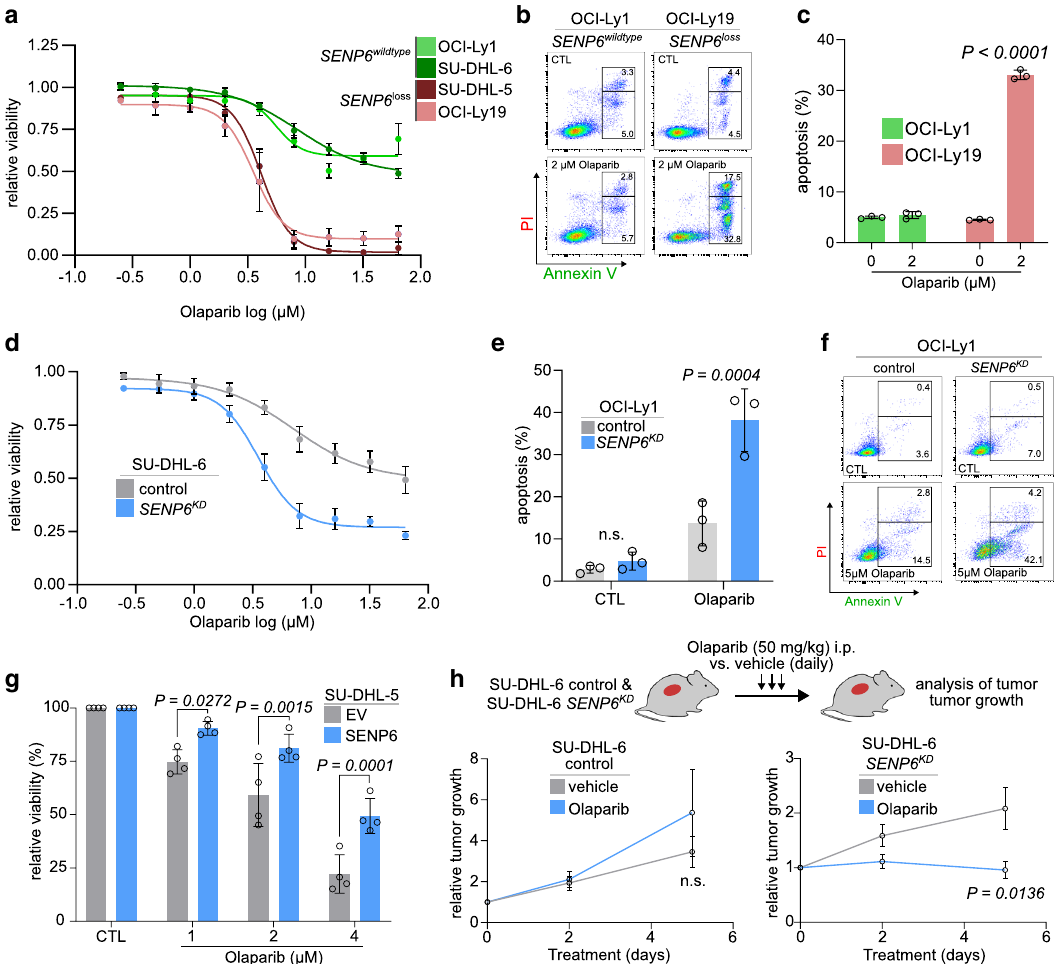
Fig. 7 SENP6 de fi ciency drives synthetic lethality to PARP inhibition. a Olaparib dose-response curves for two SENP6 wildtype and two SENP6 loss human DLBCL cell lines. Cells were treated for 72 h with olaparib and viability was determined by PI staining and fl ow cytometry measurement. Data are presented as mean ± SD from n = 3 independent experiments. b Representative plots of the fl ow cytometry experiment are described in ( c ). c Quanti fi cation of fl ow cytometry results for PI and Annexin V staining in human OCI-Ly1 and OCI-Ly19 DLBCL cell lines after olaparib treatment for 72 h. P -value determined by two-way ANOVA; Bonferroni ’ s multiple comparisons test. Data are presented as mean ± SD from n = 3 independent experiments. d Olaparib dose- response curves of SENP6 KD and control SU-DHL-6 cells. Cells were treated for 72 h and viability was determined by PI staining and fl ow cytometry measurement. Data are presented as mean ± SD from n = 3 independent experiments. e Quanti fi cation of fl ow cytometry results for PI and Annexin V staining of SENP6 KD and control OCI-Ly1 cells after olaparib treatment for 72 h. P -value determined by ANOVA; Bonferroni ’ s multiple comparisons test. Data are presented as mean ± SD from n = 3 independent experiments. f Representative plots of the fl ow cytometry experiment are described in Fig. 7e. ( g ) Viability of human SU-DHL-5 SENP6 cells relative to SU-DHL-5 EV control cells after 48 h olaparib treatment with the indicated concentrations. Viability is determined by DAPI staining and fl ow cytometry measurement. P -value determined by two-way ANOVA; Bonferroni ’ s multiple comparisons test. Data are presented as mean ± SD from n = 4 independent experiments. h The human SU-DHL-6 SENP6 KD and control SU-DHL-6 cell line was used to generate murine xenograft models in NOD scid mice. Mice were treated with vehicle or 50 mg/kg olaparib by intraperitoneal injection daily and tumor size was measured over time. Tumor size at day 5 of olaparib treated SENP6 KD SU-DHL-6 mice revealed a signi fi cant reduction in tumor size in treated mice. SU-DHL-6 control: vehicle ( n = 5) and olaparib ( n = 6). SU-DHL-6 SENP6 : KD vehicle ( n = 5) and olaparib ( n = 7). P -value was determined by unpaired t - test (two-tailed). Data are presented as mean ± mediated depletion of SENP6 in SU-DHL-6 (Supplementary Fig. 13a, b) and OCI-Ly1 cells led to a striking increase in ola- parib sensitivity when compared to control cells, demonstrating that olaparib-induced cell death is dependent on the SENP6 status (Figs. 7d and S13c). Accordingly, we observed increased apoptotic cell death in SENP6-depleted OCI- Ly1 cells after olaparib treatment (Figs. 7e, f and S13d). In support of this observation, ectopic expression of SENP6 increased the resistance of SU-DHL-5 cells to olaparib treatment in comparison to SU-DHL-5 EV control cells (Figs. 7g and S13e, f).